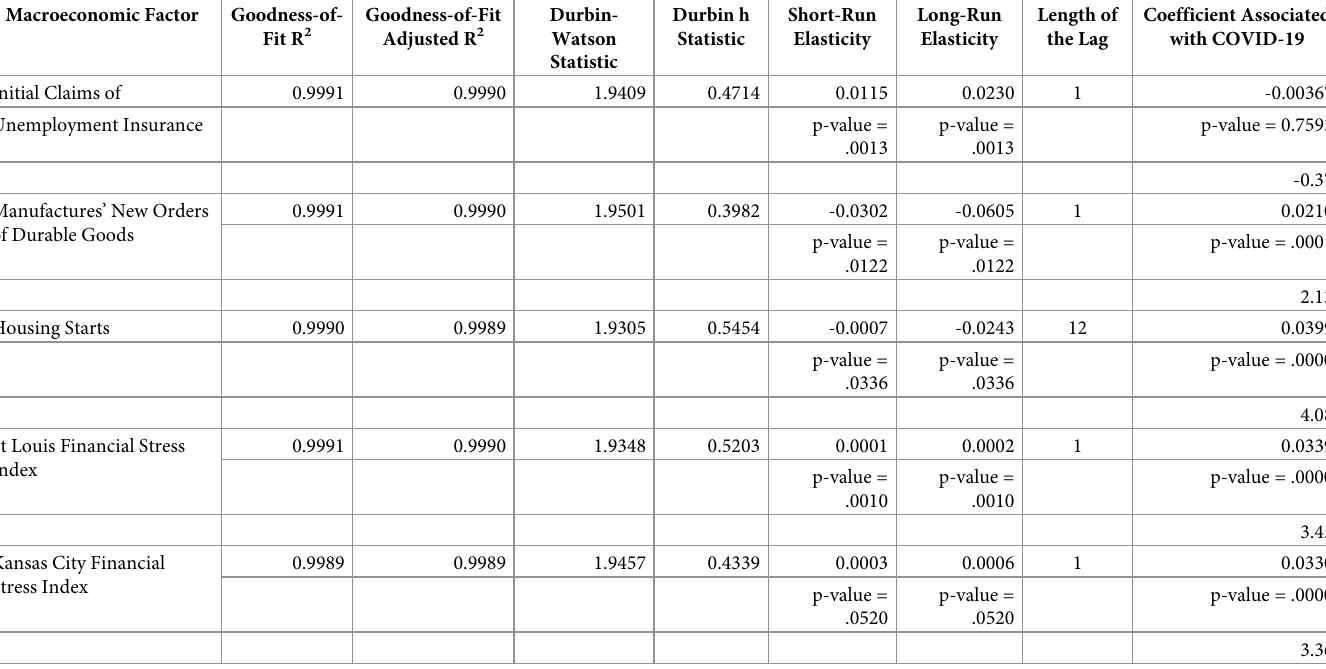
Table 2. Key metrics of the econometric distributed lag models concerning SNAP Participation by macroeconomic